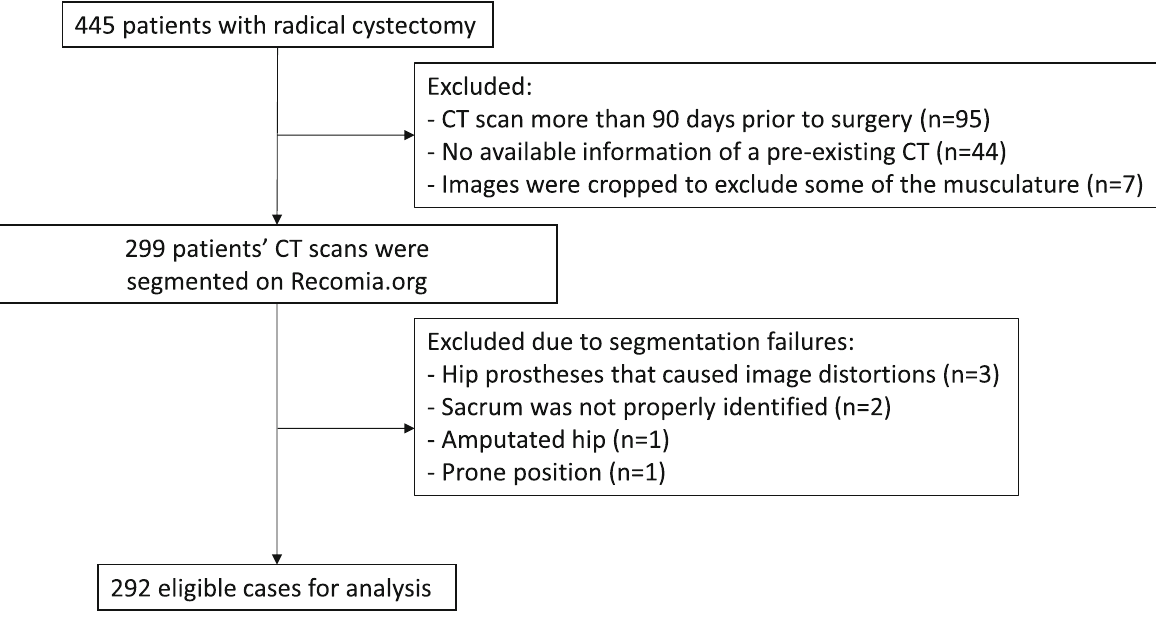
Fig. 1 Flow chart of inclusion and exclusions of patients in the study. CT computed